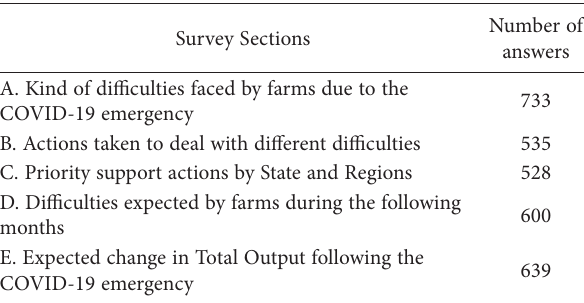
Table 1. Structure of questionnaire and number of respondents. Survey